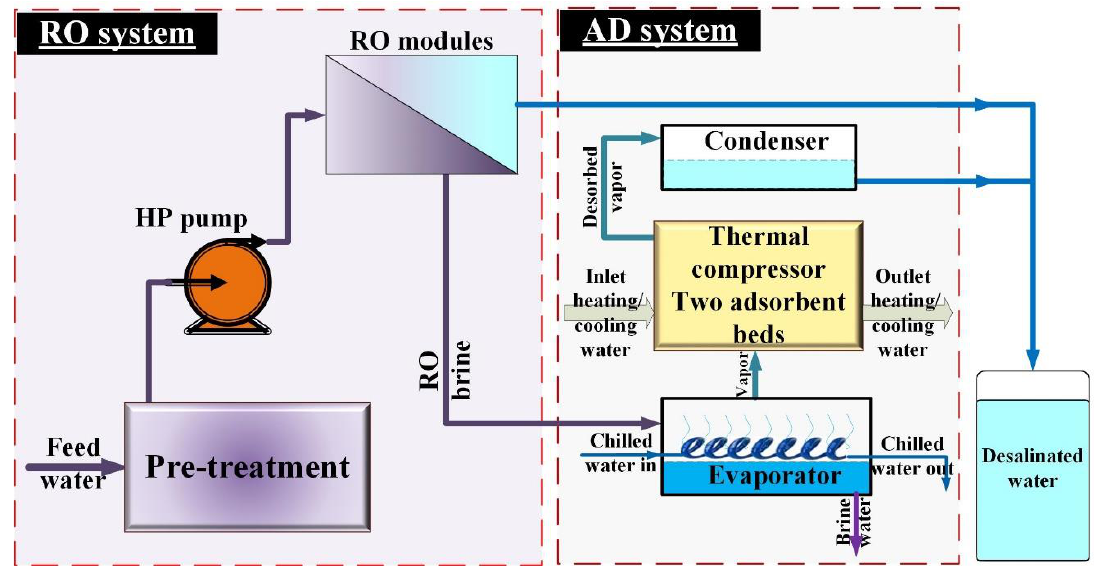
Figure 4. The RO-ADC system diagram (Adapted from [84]).